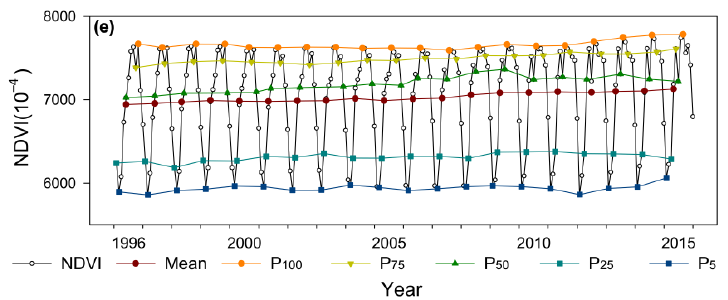
Figure A1. Changes in NDVI during each year of the 15-year windows. The horizontal axis is the upper limit year of the 15-year moving window, with 1996, 1997, … , 2015, representing the mobile windows of 1982 – 1996, 1983 – 1997, … , and 2001 – 2015, respectively. P 100 , P 75 , P 50 , P 25 , and P 5 , individually represent the filter month in which the occurrence occurs from the moving window, and the Mean refers to the month closest to the Mean. ( a – e ) separately refer to the SW, T + *-P + *, T + *-P − , T + *-P + , and NSC.